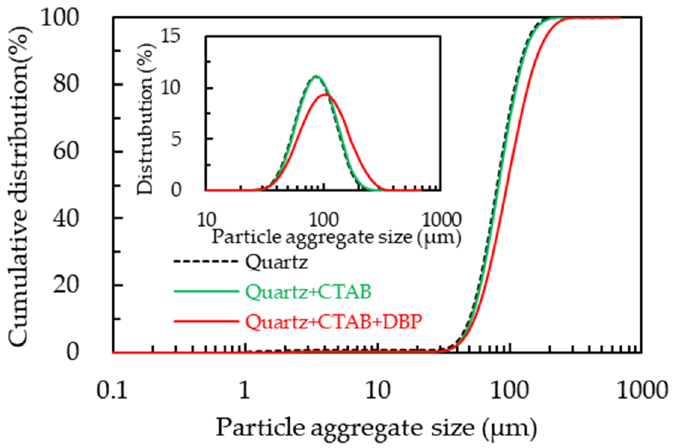
Figure 5. Aggregation states of quartz particles with and without DBP.